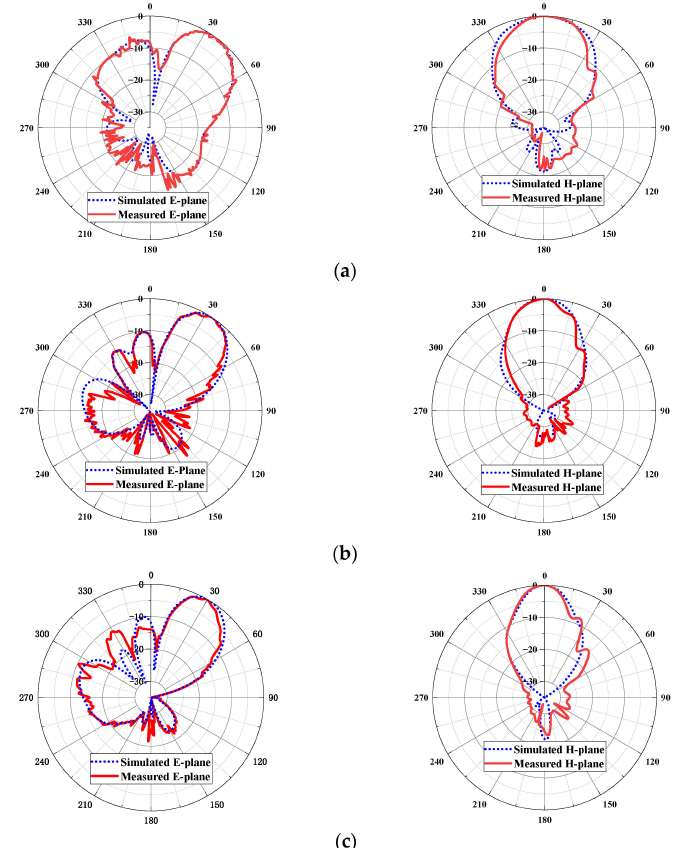
Figure 11. The simulated and measured radiation patterns of the proposed antenna, ( a ) 80 GHz; ( b ) 94 GHz; ( c ) 100